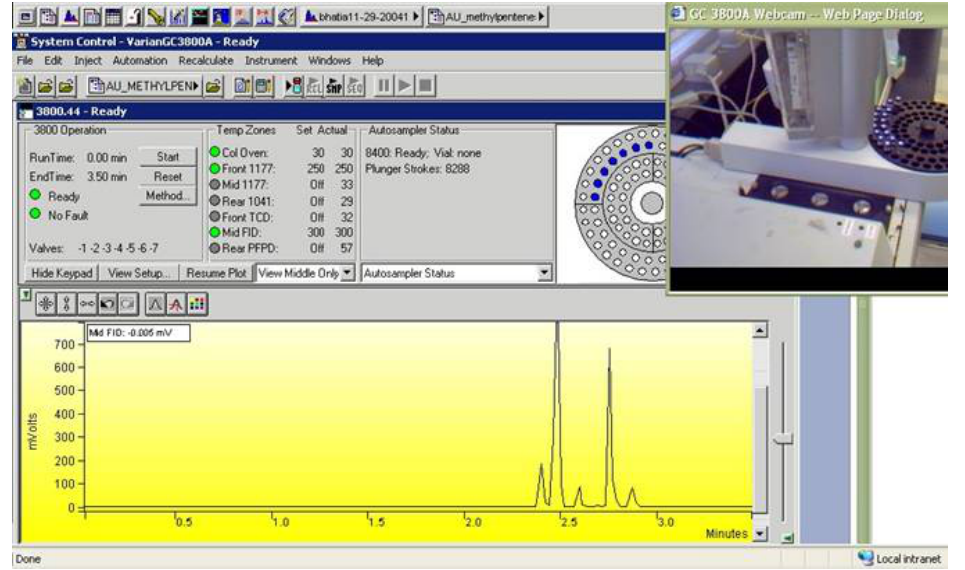
Figure 3. Actual instrument access of chromatography experiment in progress with web camera view (insert) in